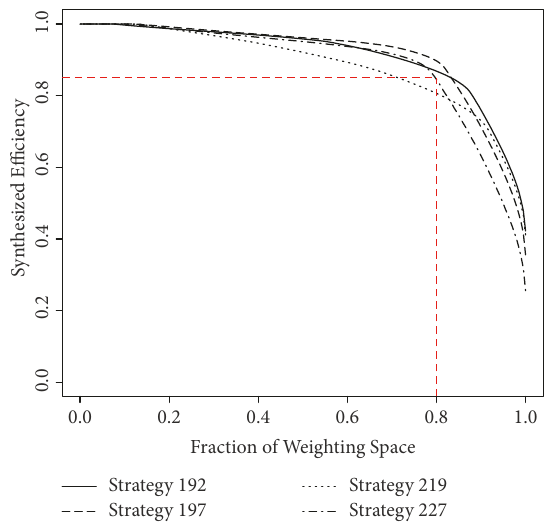
Figure 14: Fraction of Weight Space (FWS) plot for the four most promising strategies.